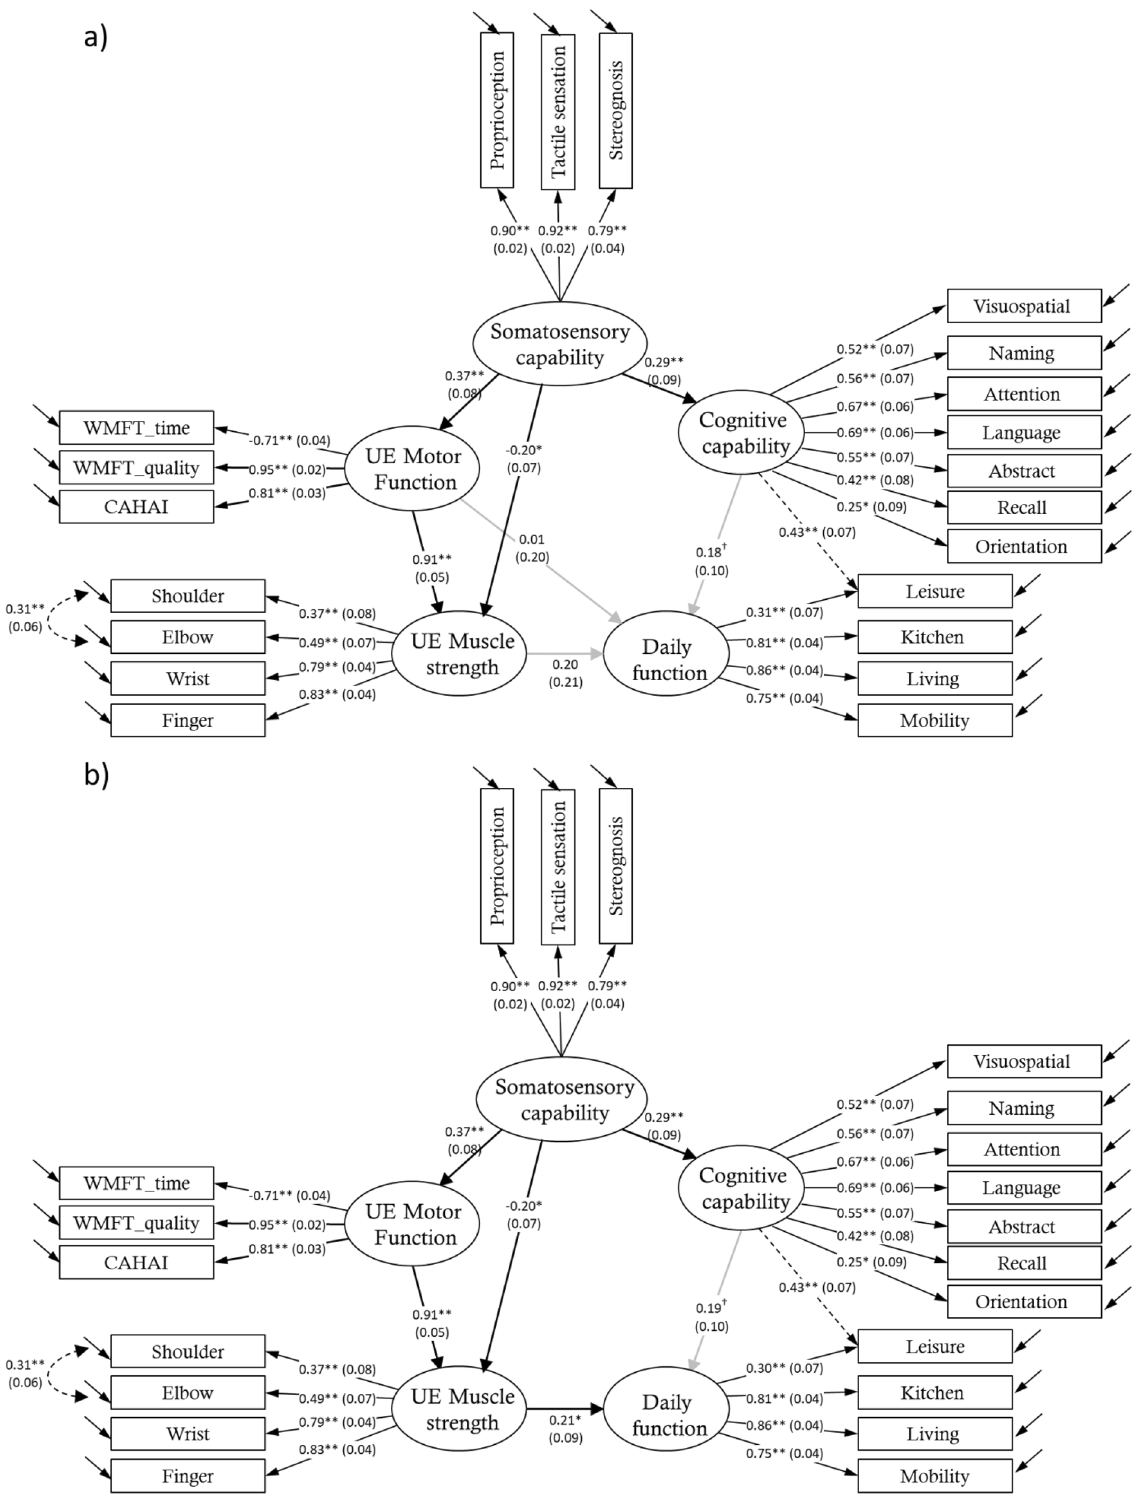
Figure 2. SEM analysis of the modified structural model. The values of the standardized results and the standard errors (in the parentheses) are shown. Dark arrows indicate statistically significant results, and gray arrow indicates non-significant result. ( a ) It represents the structural model revised by the recommendations of the LM test. ( b ) It represents a revised model that removed the path from the UE motor function to the independence in daily function considering the results of the Wald test and the model simplicity. † P < 0.10; * P < 0.05; ** P <